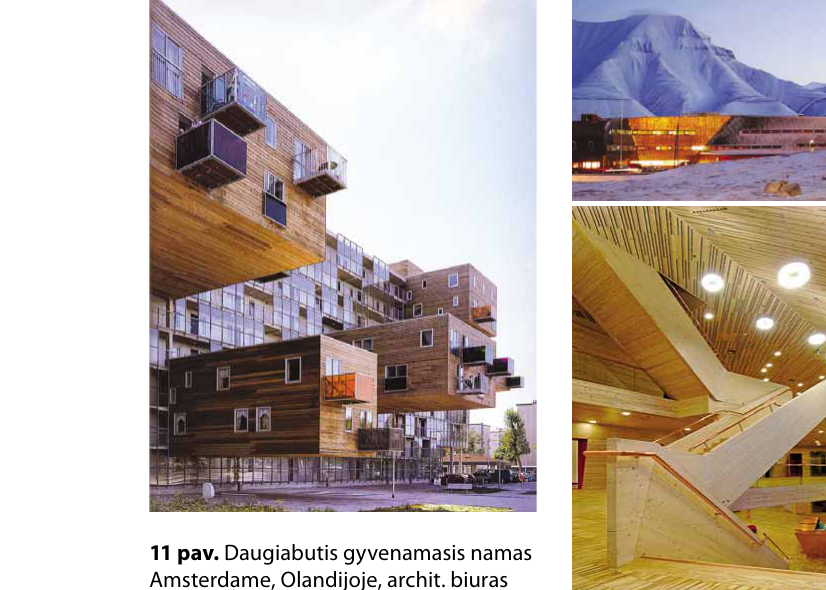
Fig. 11. Apartment house in Amsterdam, Holland, archit. office “MVRDV”, 1997 m.